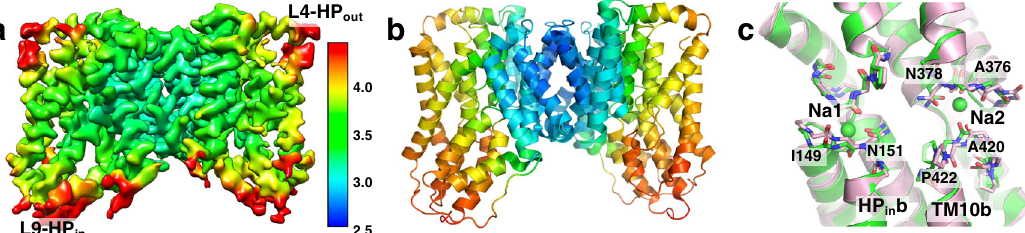
Fig. 2 Cryo-EM structure of VcINDY in the C i - apo state determined in Choline + . a Cryo-EM map of VcINDY preserved in amphipol determined in the presence of 100 mM Choline Chloride. The map is colored by local resolution (Å) on the same scale as Fig. 1b and contoured at 4.8 σ . The overall map resolution is 3.23 Å. The two previously-identi fi ed hinge regions which facilitate movement of the transport domain 19 , L4-HP in and L9-HP out , are found to be most fl exible. b Structure of VcINDY in the C i - apo state. The structure is colored by the B-factor on the same scale as Fig. 1b. c Overlay of VcINDY structures around substrate and sodium binding sites in the sodium-bound C i -Na + state (green) and the C i - apo state (pink). The structures of the two Na1 and Na2 clamshells have changed in the absence of sodium ions, particularly around residues Ile149, Asn151, Ala376, Asn378, Ala420 and